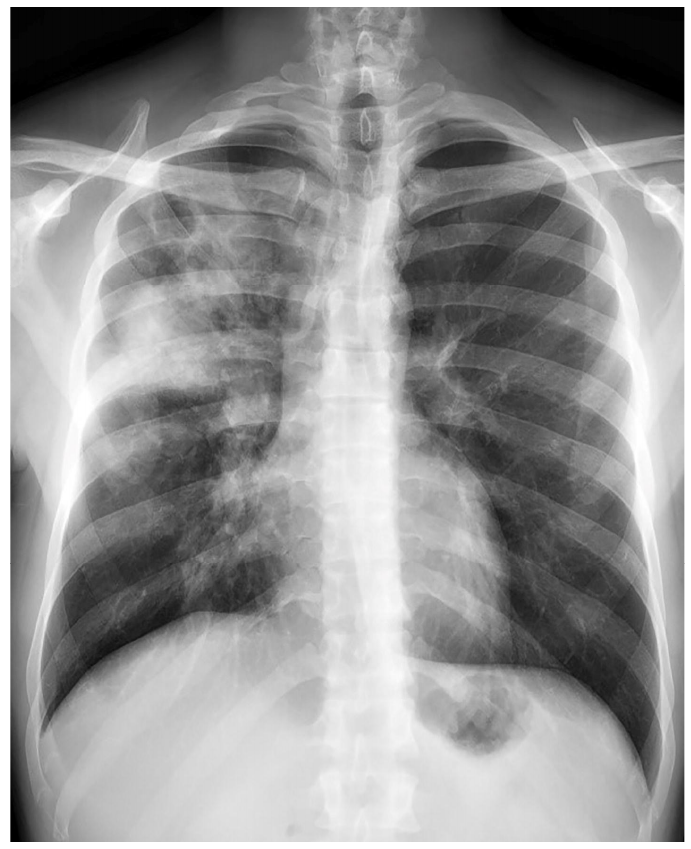
Figure 3. Case 7, beginning of the treatment.